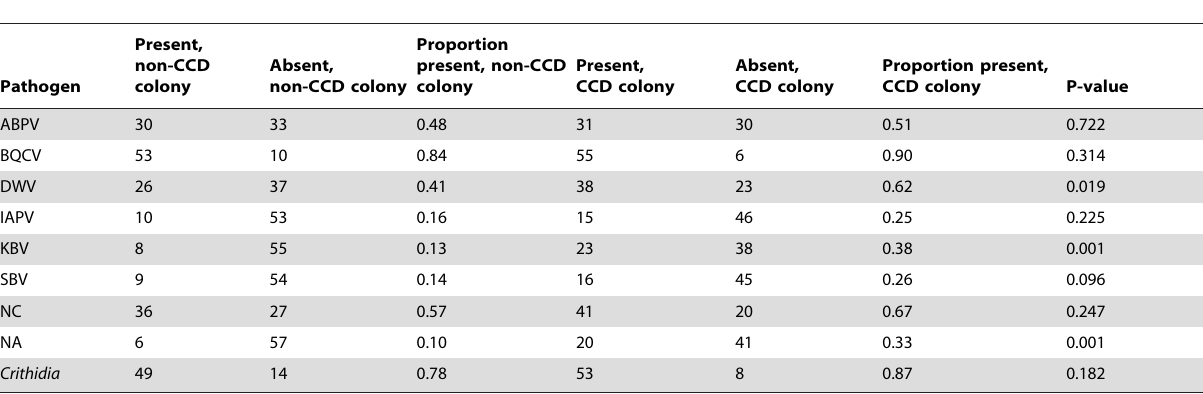
Table 1. Honey-bee pathogen incidence by colony status.